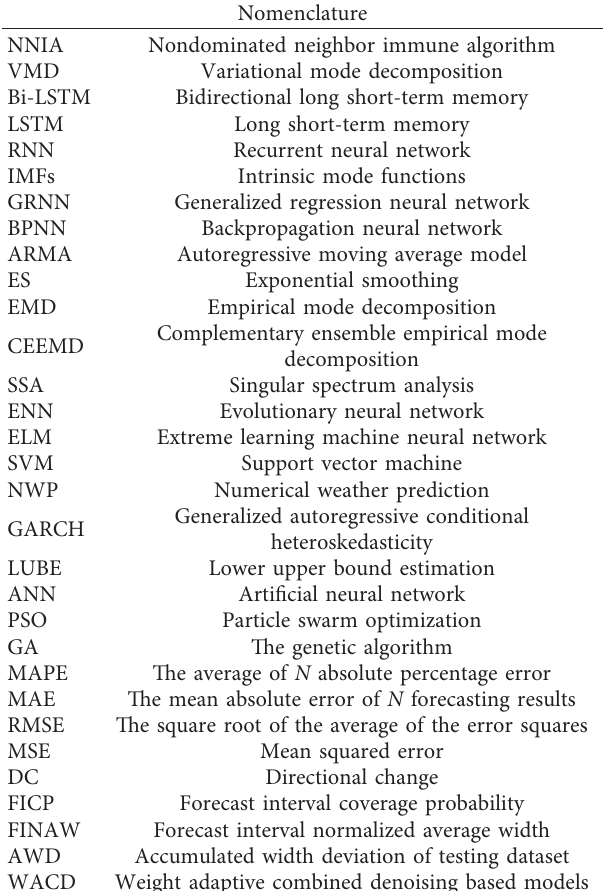
Table 2: The abbreviations that appear in this